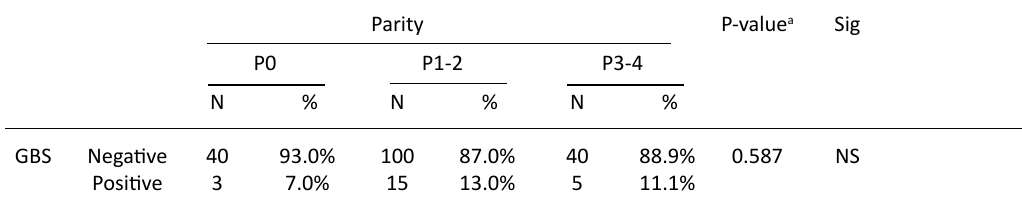
Table 3. Relationship between Previous abortion and GBS result among cases Previous abortion P-value a Sig No Yes N %